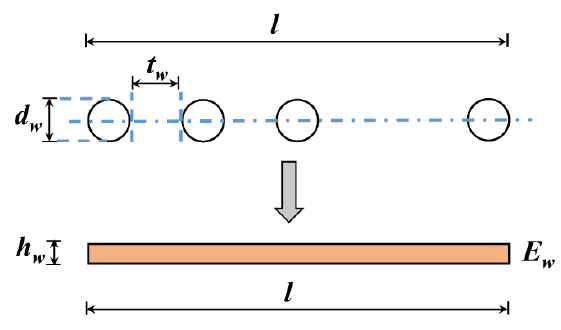
Figure 1. Equivalence of cofferdam structure.